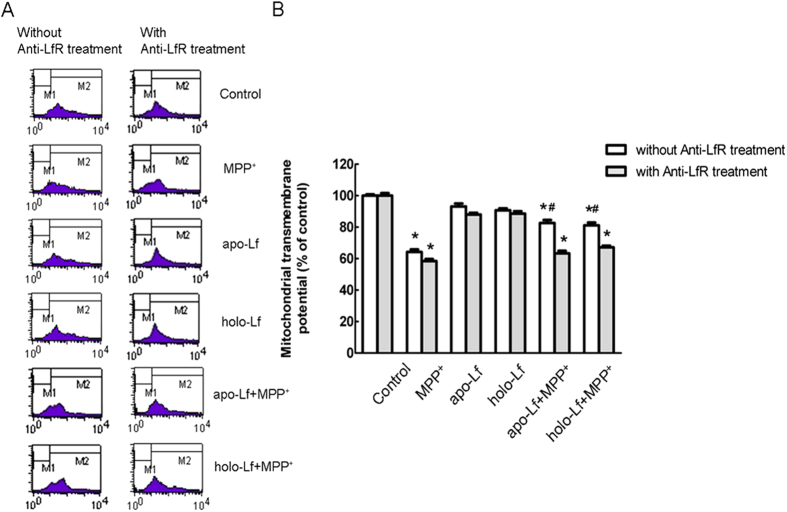
ΔΨm assessed by flow cytometry in VM neurons with blocking LfR.To block binding of ligands to LfR, VM neurons were treated with Anti-LfR for 1 h at 37 °C. Then, VM neurons were treated with 100 ng/ml apo-Lf or 100 ng/ml holo-Lf for 4 h followed by 100 μmol/L MPP+ for 24 h. (A) Representatives of the fluorometric assay on ΔΨm of different groups. Results are shown as FL1-H (fluorescence 1-histogram), setting the gated region M1 and M2 as a marker to observe the changing levels of fluorescence intensity using CellQuest software. Numbers in the M1 gate of the dot-plots show the percentage of apoptotic cells. The ΔΨm was decreased in MPP+-treated apoptotic cells and the ratio of M1 area was increased. 100 ng/ml apo-Lf or holo-Lf pretreatment significantly restored the ΔΨm reduction induced by MPP+. Blocking LfR significantly attenuated the protective effect of Lf in VM neurons induced by MPP+. X mean = mean channel fluorescence of FL-1; Y mean= the number of living cells. (B) Statistical analysis. Data were presented as mean ± S.E.M. of three independent experiments. Fluorescence values of the control were set to 100%. *P < 0.05, compared with the control; #P < 0.05, compared with MPP+ group; n = 6.